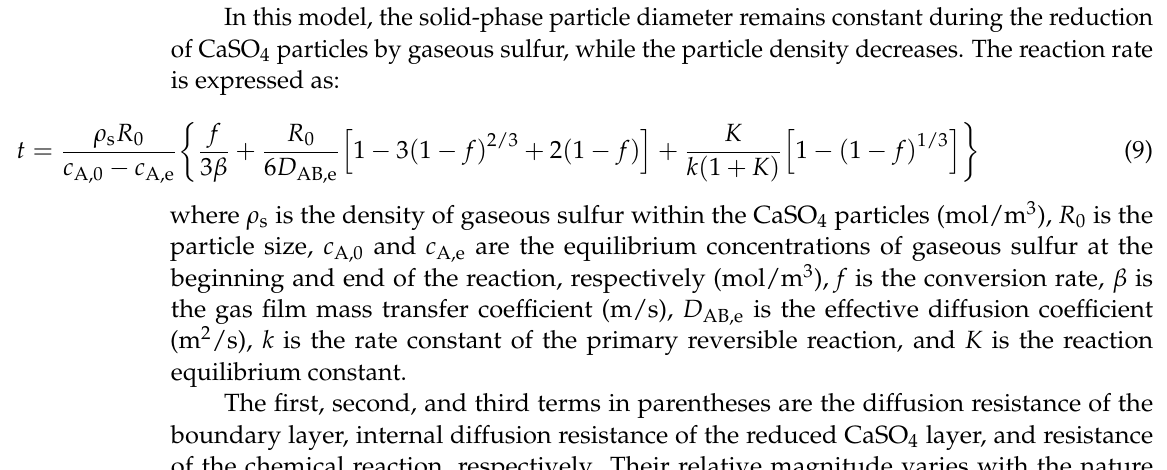
particle size, c A,0 and c A,e are the equilibrium concentrations of gaseous sulfur at the beginning and end of the reaction, respectively (mol/m 3 ), f is the conversion rate, β is the gas film mass transfer coefficient (m/s), D AB,e is the effective diffusion coefficient (m 2 /s), k is the rate constant of the primary reversible reaction, and K is the reaction equilibrium constant. The first, second, and third terms in parentheses are the diffusion resistance of the boundary layer, internal diffusion resistance of the reduced CaSO 4 layer, and resistance of the chemical reaction, respectively. Their relative magnitude varies with the nature of the solid phase particles, ambient fluid velocity, temperature, particle size, and other factors. Furthermore, this leads to the variation in the limiting link during the reduction reaction process. The relative magnitudes of the influence of the aforementioned links can be obtained from the relative magnitudes of β , D AB,e , and k . The common reaction mechanism identification effects are listed in Table 2 Table 2. Identification of reaction mechanism in different limiting steps.